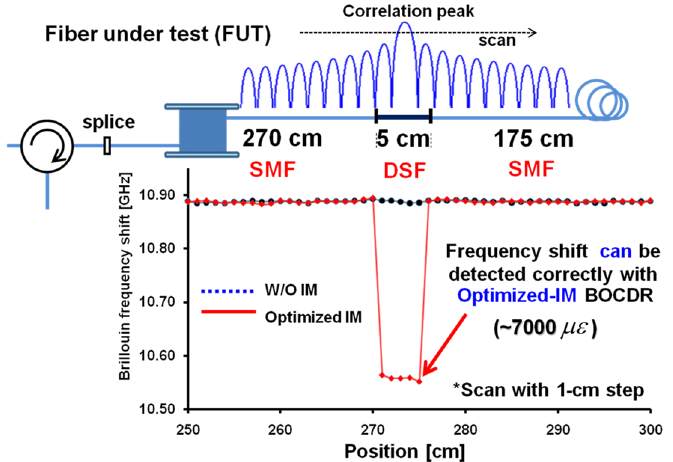
Figure 33. Experimental results of the distributed BFS measurement at the five-cm DSF section with one-cm spatial resolution [83]. The DSF section can be recognized due to the intensity modulation scheme.